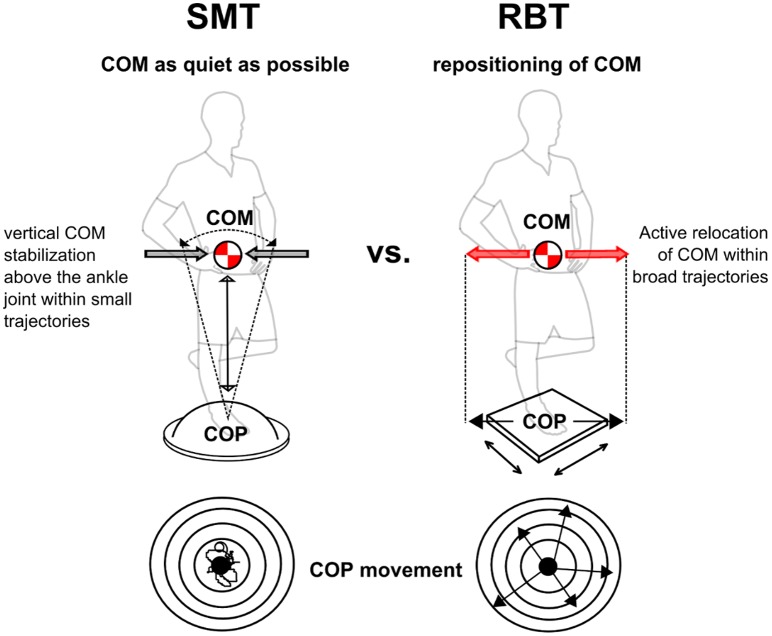
Biomechanical characteristics of the two selected balance trainings: the sensorimotor training (SMT, left) and reactive balance training (RBT, right) intervention.During SMT, the center of mass (COM) needs to be kept as still as possible and stability is reached when the COM stays solidly with the body as an inverted pendulum rotating around the ankle joint. During RBT, after each perturbation of the support surface, the COM needs to be actively relocated through the proximal segment to keep a stable equilibrium.